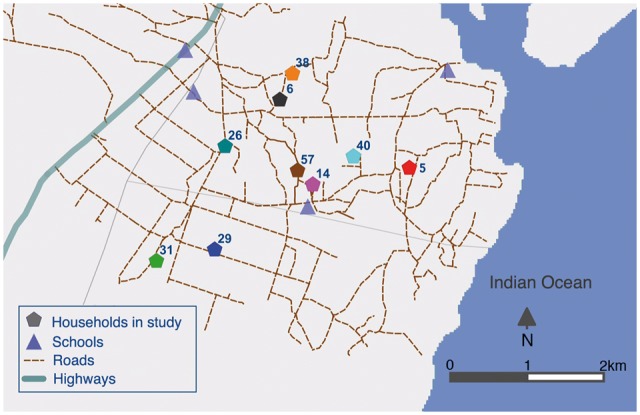
Geographical distribution of the nine studied households which each had at least one assembled genome. Also shown is the Mombasa-Malindi highway, roads and schools in the study area. Light grey lines indicate administrative sub-location boundaries.